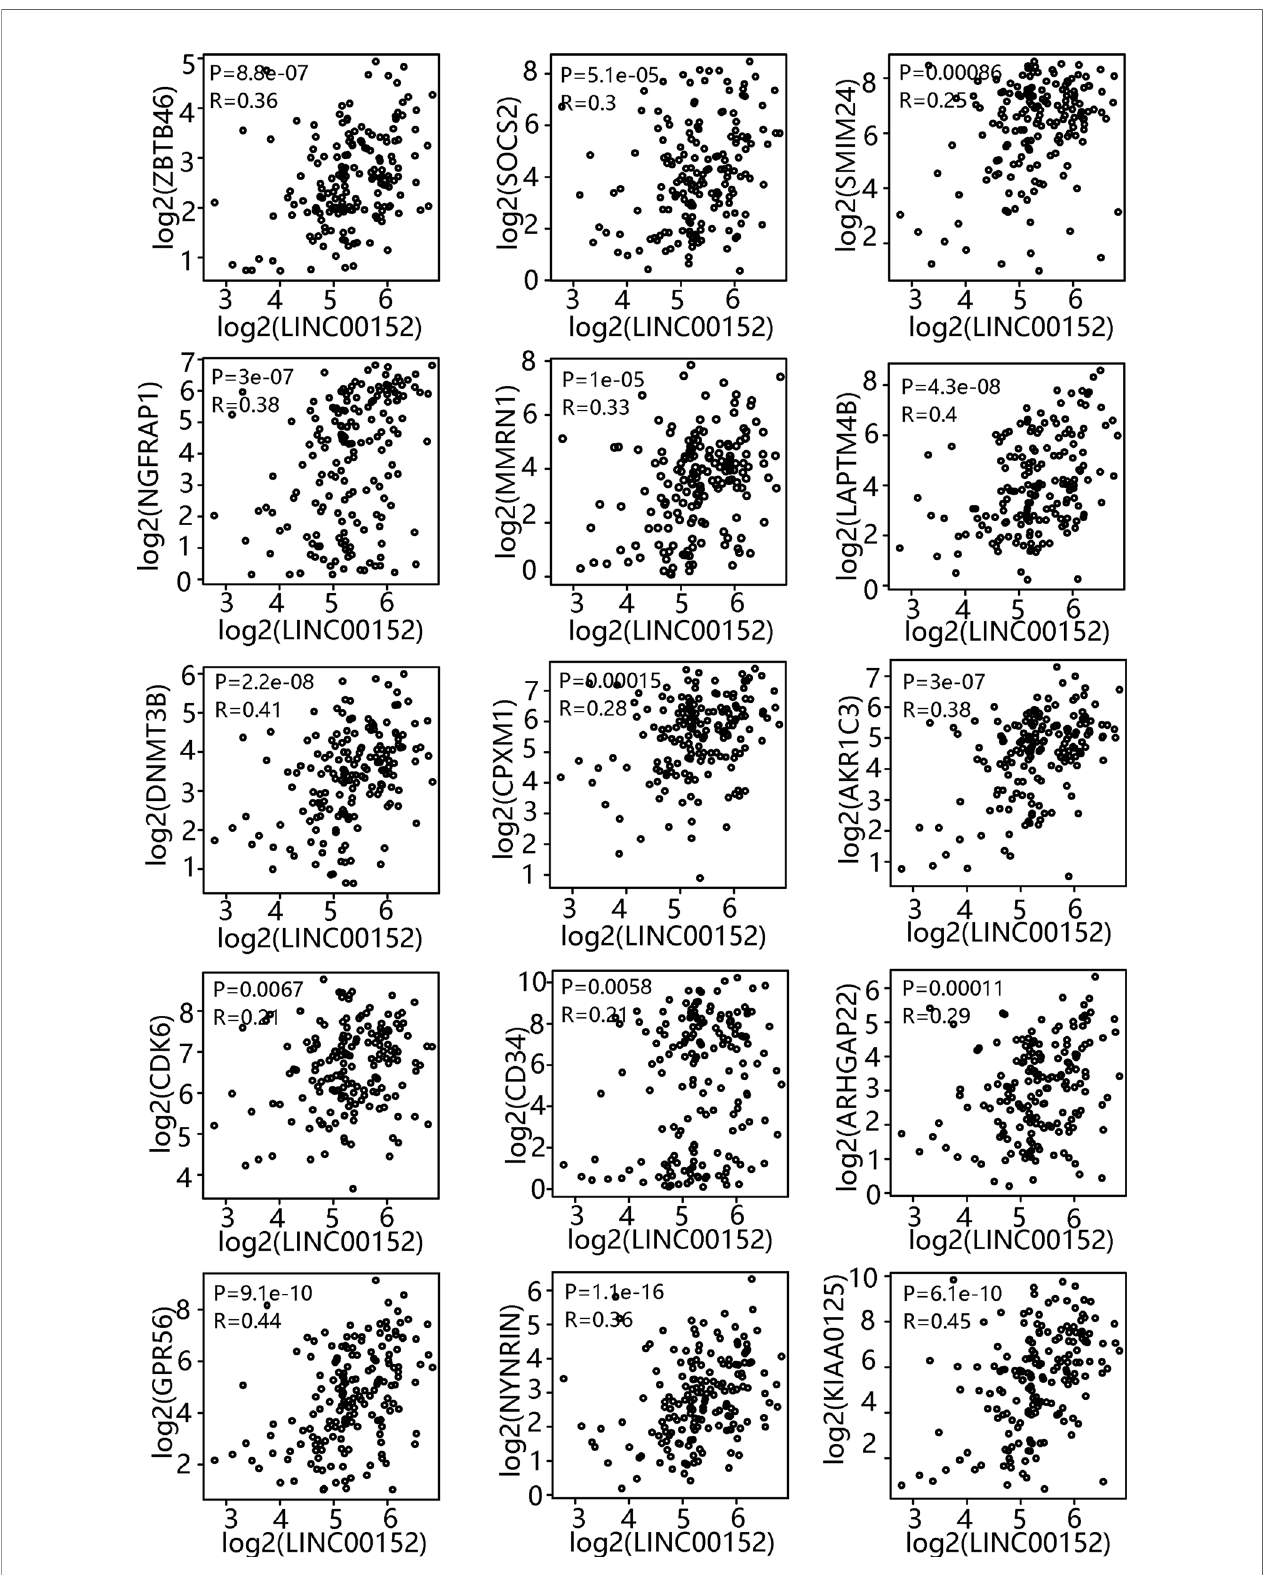
FIGURE 2 | Correlation between LINC00152 expression and leukemia stem cell (LSC)-associated gene expression. LSC17 biomarker gene pro fi le and LINC00152 expression were analyzed based on a publicly available data set (GSE76009) by gene expression pro fi ling interactive analysis.